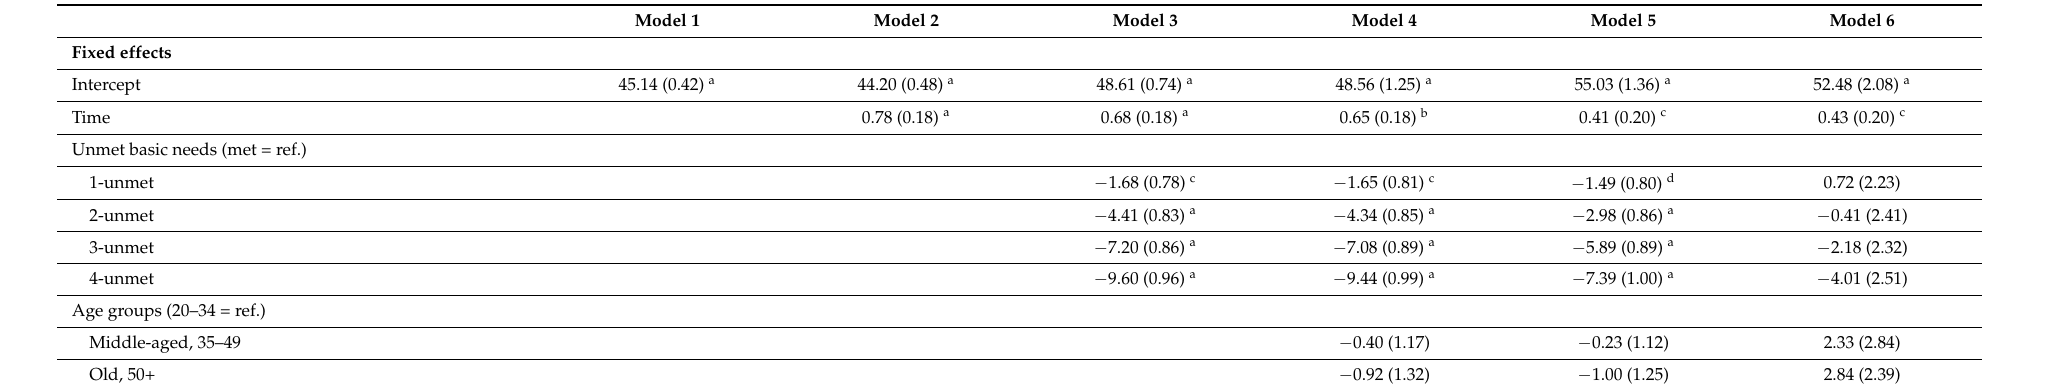
Table 3. Individual growth curve models for changes in Mental Health Summary (2006–2009) in Positive Spaces, Healthy Places (n =